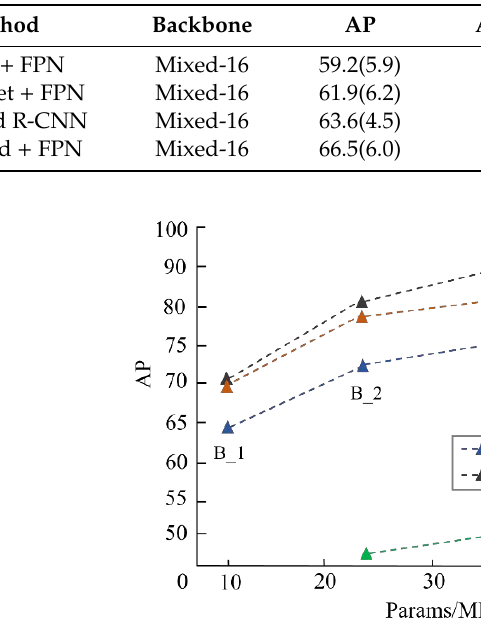
Figure 11. The performance of different configurations of CI-FPN with CG-RPN modules.